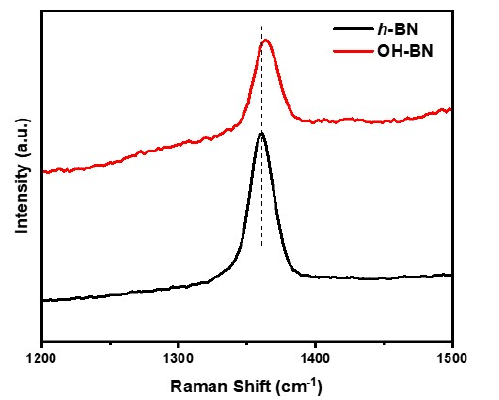
Figure 4. Raman spectra of the h -BN (black) and OH-BN (red) particles.